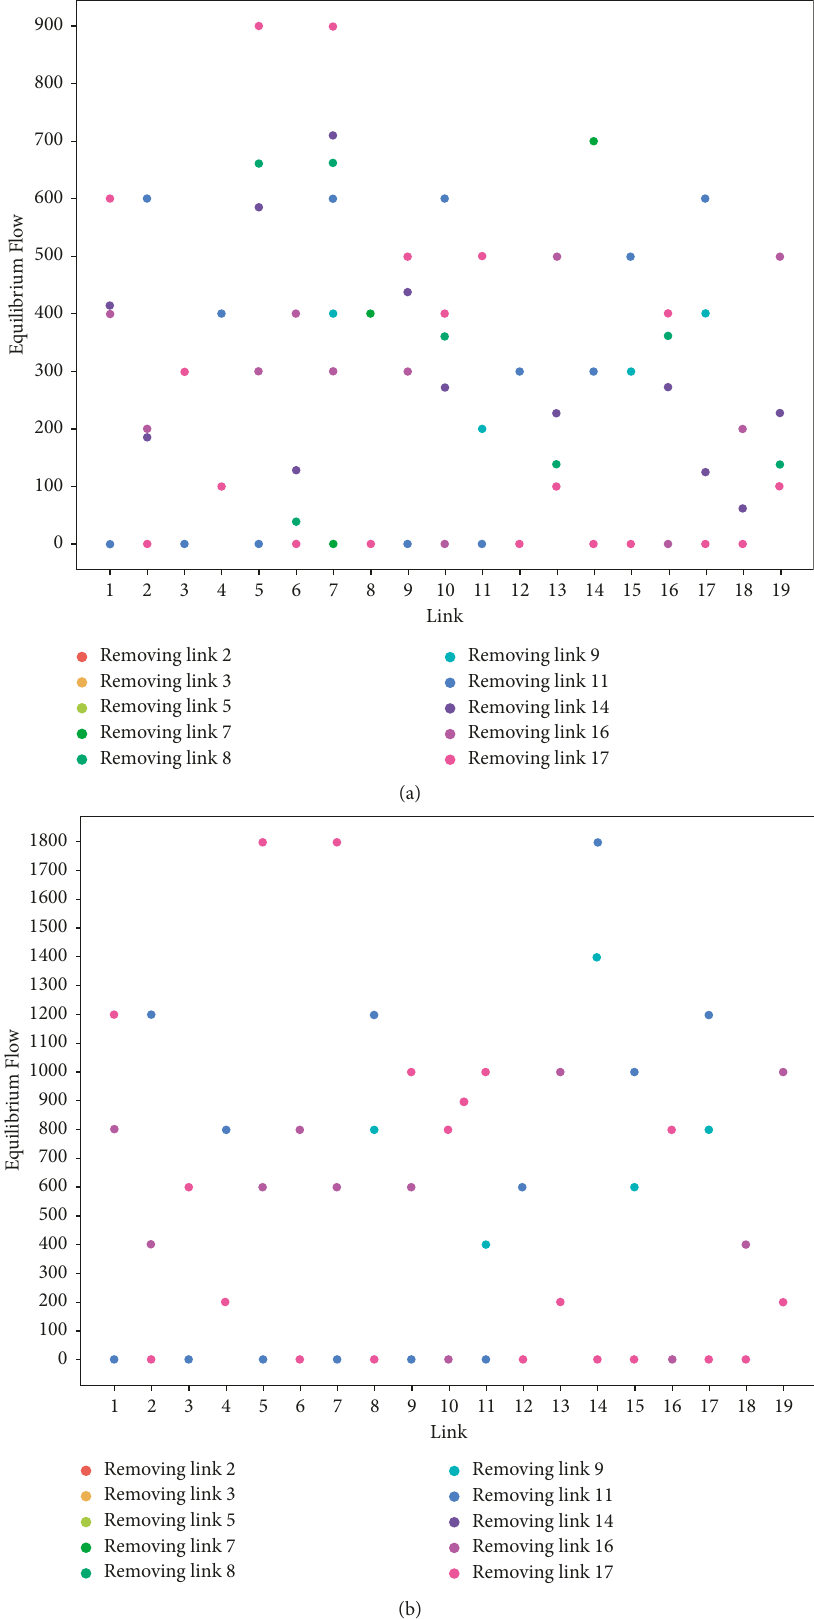
Figure 2: Equilibrium solutions: (a) under normal demand level; (b) under high demand